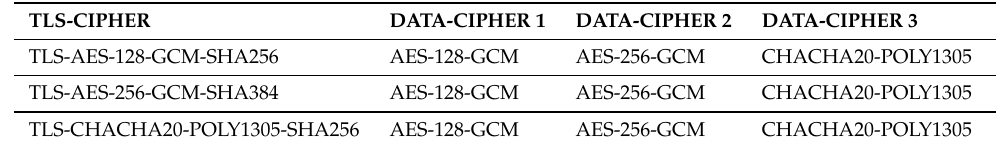
Table 5. OpenVPN using different encryption algorithms configuring TLS-cipher suites and data-